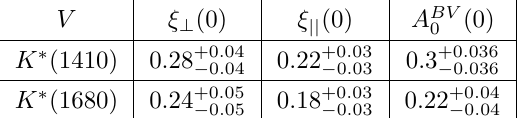
Table 11 . Values of the parameters in the vector form-factors (F.21) from [53,